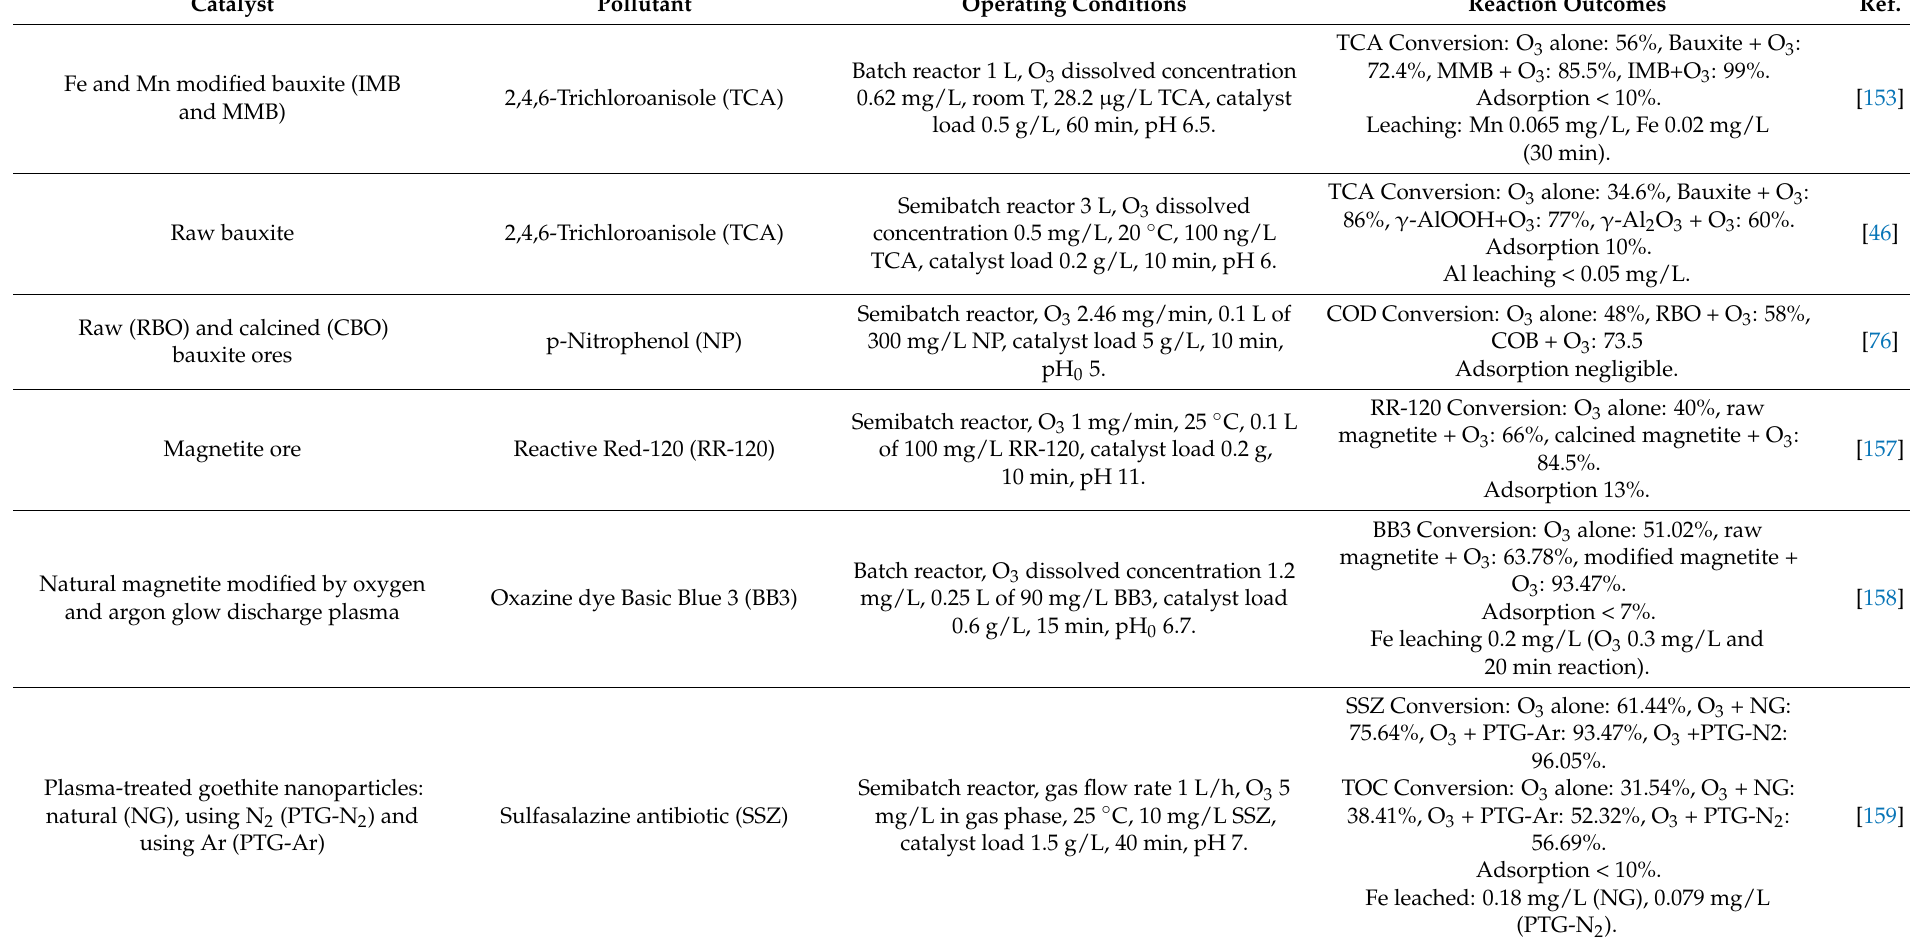
Table 3. Natural oxides as catalysts in the ozonation of organic